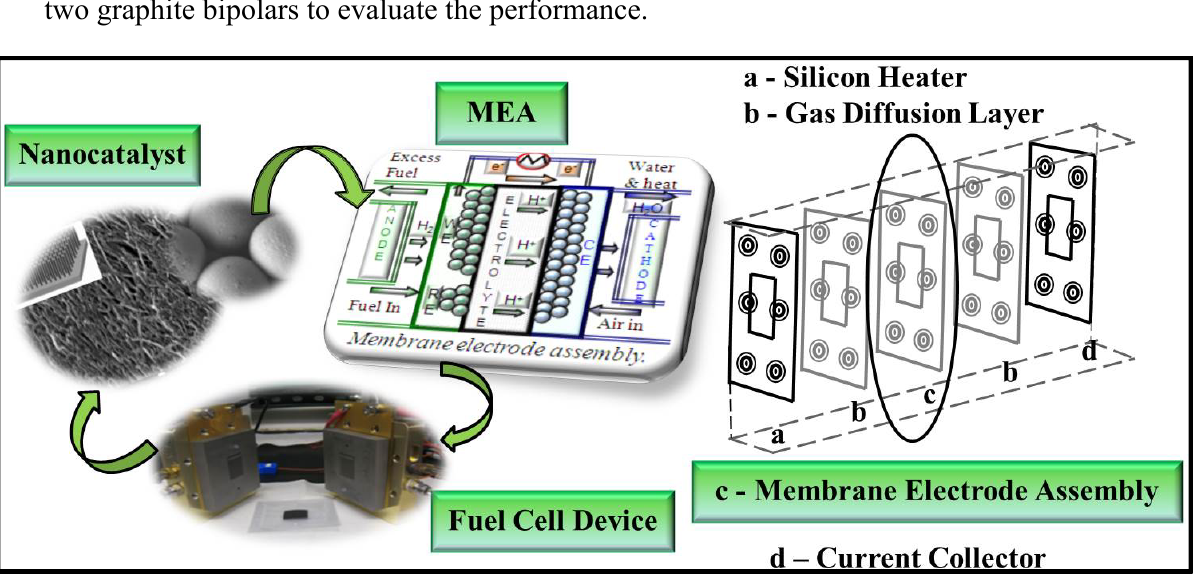
Figure 2. The hierarchy of the nano-micro-macro integration: platinum-carbon nanotube (Pt-CNT) arrays as cathode catalyst; metal-organic frameworks (MOFs)-Co/Ni as anode catalyst and gas storage. The membrane electrode assembly (MEA) was packaged between two graphite bipolars to evaluate the